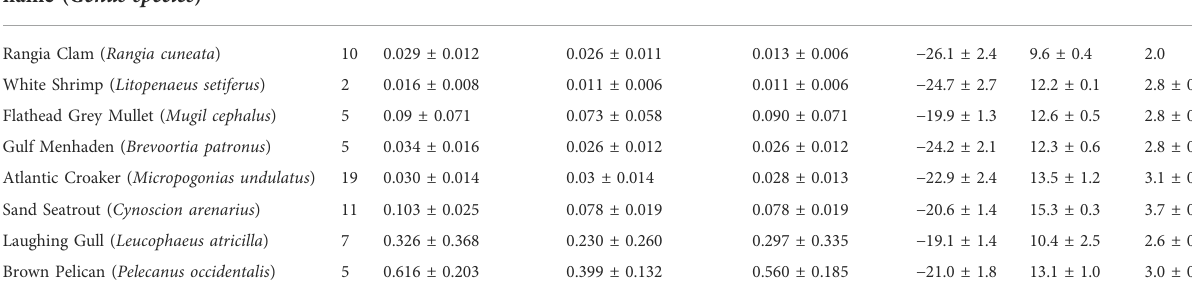
TABLE 2 Stable isotope values and Hg concentrations of consumers from coastal Alabama derived from Showalter (2010). Hg concentrations were convertedfromtheoriginalwetwt.measurementtodrywt.usingmoisturepercentagesestimatedfrommoisturecontentmeasuredinLouisiana species. Trophic position (TP) estimates were estimated using δ 15 N of bivalves as the isotopic baseline to compare subsequent consumers. MeHg concentrations were estimated using literature values averaged across groups of seabirds, fi shes, and species-speci fi c invertebrates (Table 1). The total number (N) of individuals sampled is reported for each species along with mean ±1 standard deviation for each